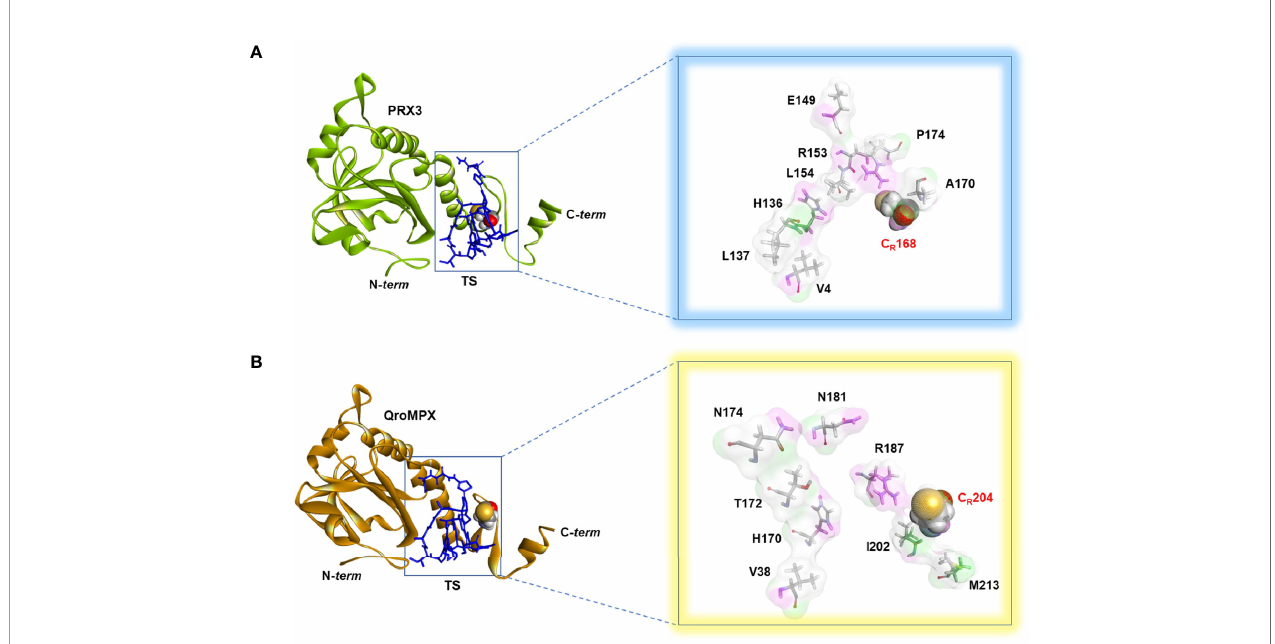
FIGURE 4 | TS-PRX3 and TS-QroMPX Docking. (A) Binding mode between TS (blue sticks) and human PRX3 (green). The amino acids (sticks format) and cysteine resolutive (ball format) involved in the interaction are shown in the box. (B) Binding mode between TS (blue sticks) and QroMPX (orange). The amino acids (sticks format) and cysteine resolutive (ball format) involved in the interaction are shown in the